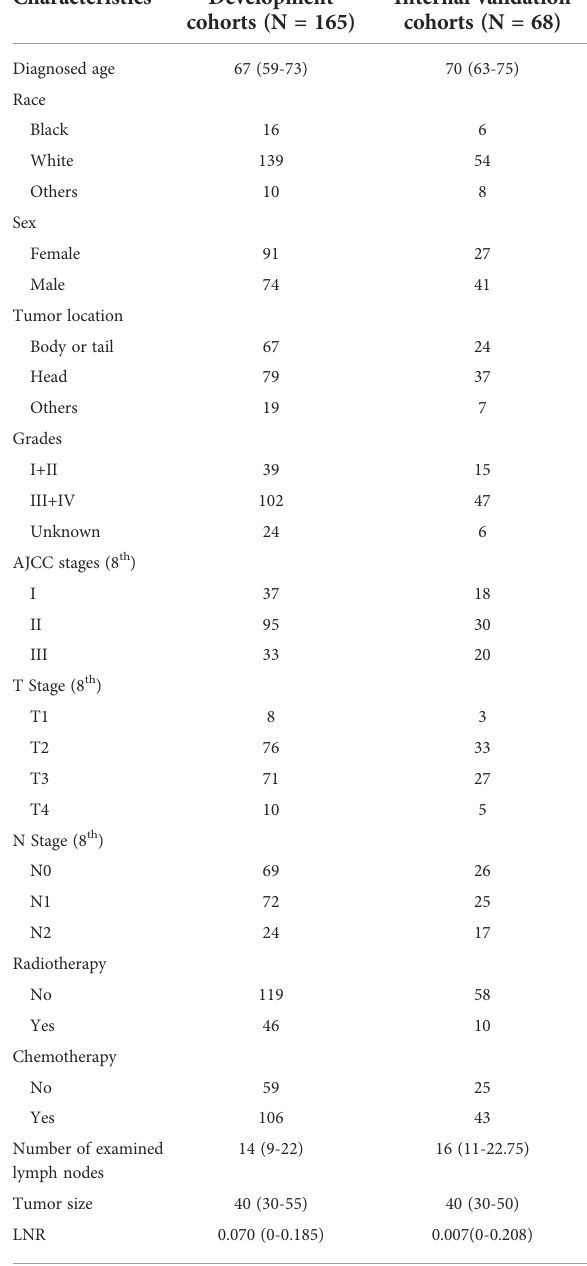
TABLE 2 Clinical characteristics of the ASCP patients from SEER in the development and internal validation cohorts.